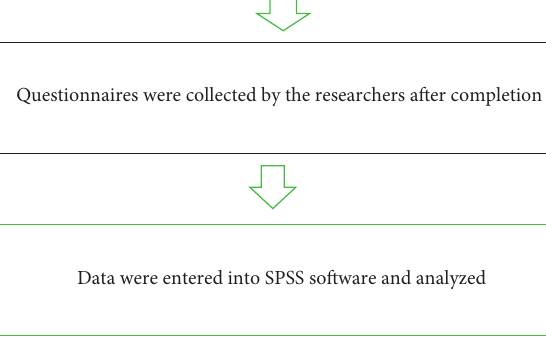
Figure 1: Study flow